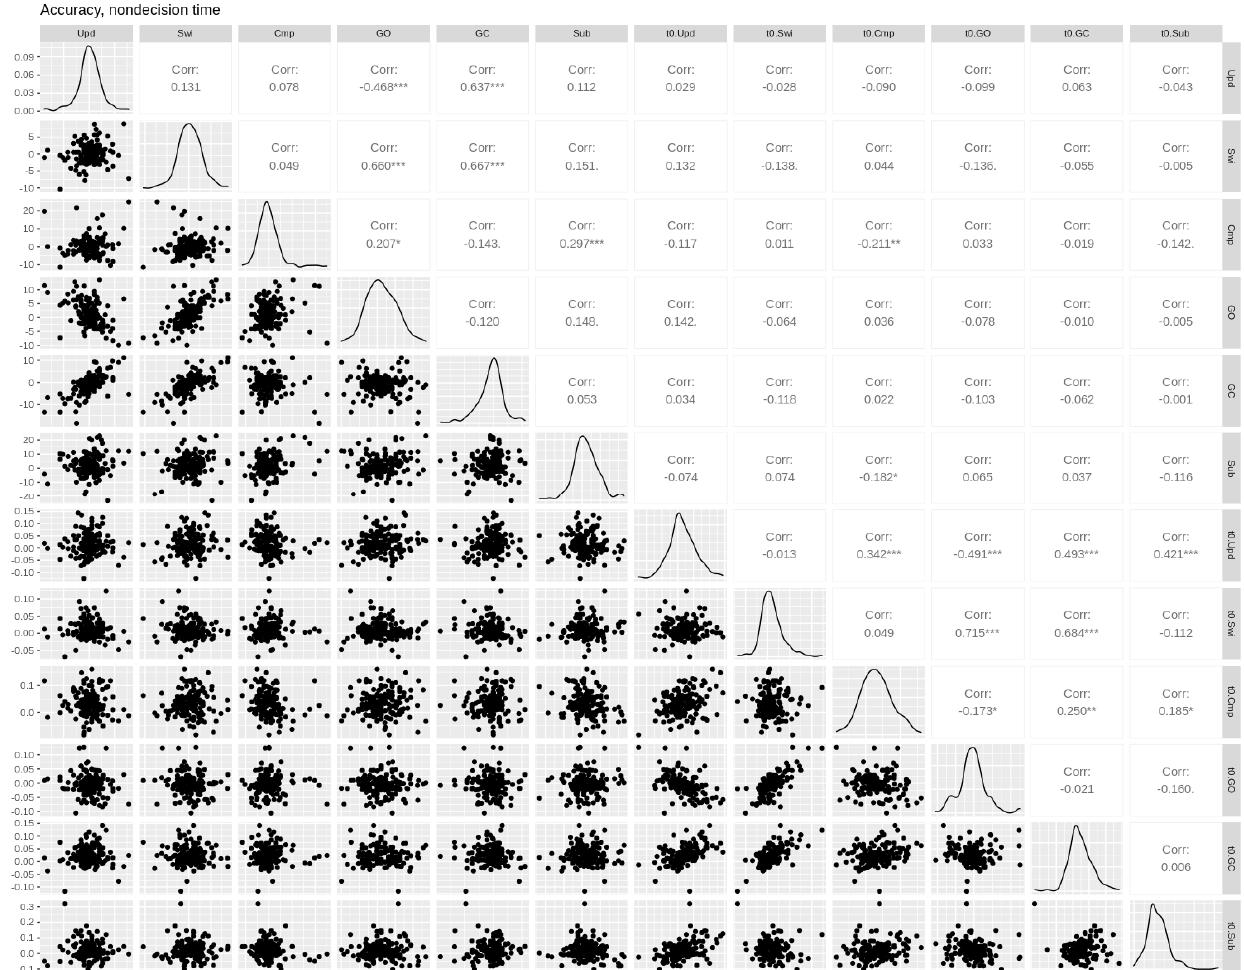
Figure A4. Pairwise Pearson correlations between non ‐ decision time and accuracy cost effects. Empirical effects are shown in the first six columns. Parameter effects are shown in the last six columns (prefixed with the parameter name). Upd = updating, Swi = switching, Cmp = comparison, GO = gate opening, GC = gate closing, Sub = substitution. Asterisks *, **, and *** denote p ‐ values of <0.05, <0.01, and <0.001, respectively.